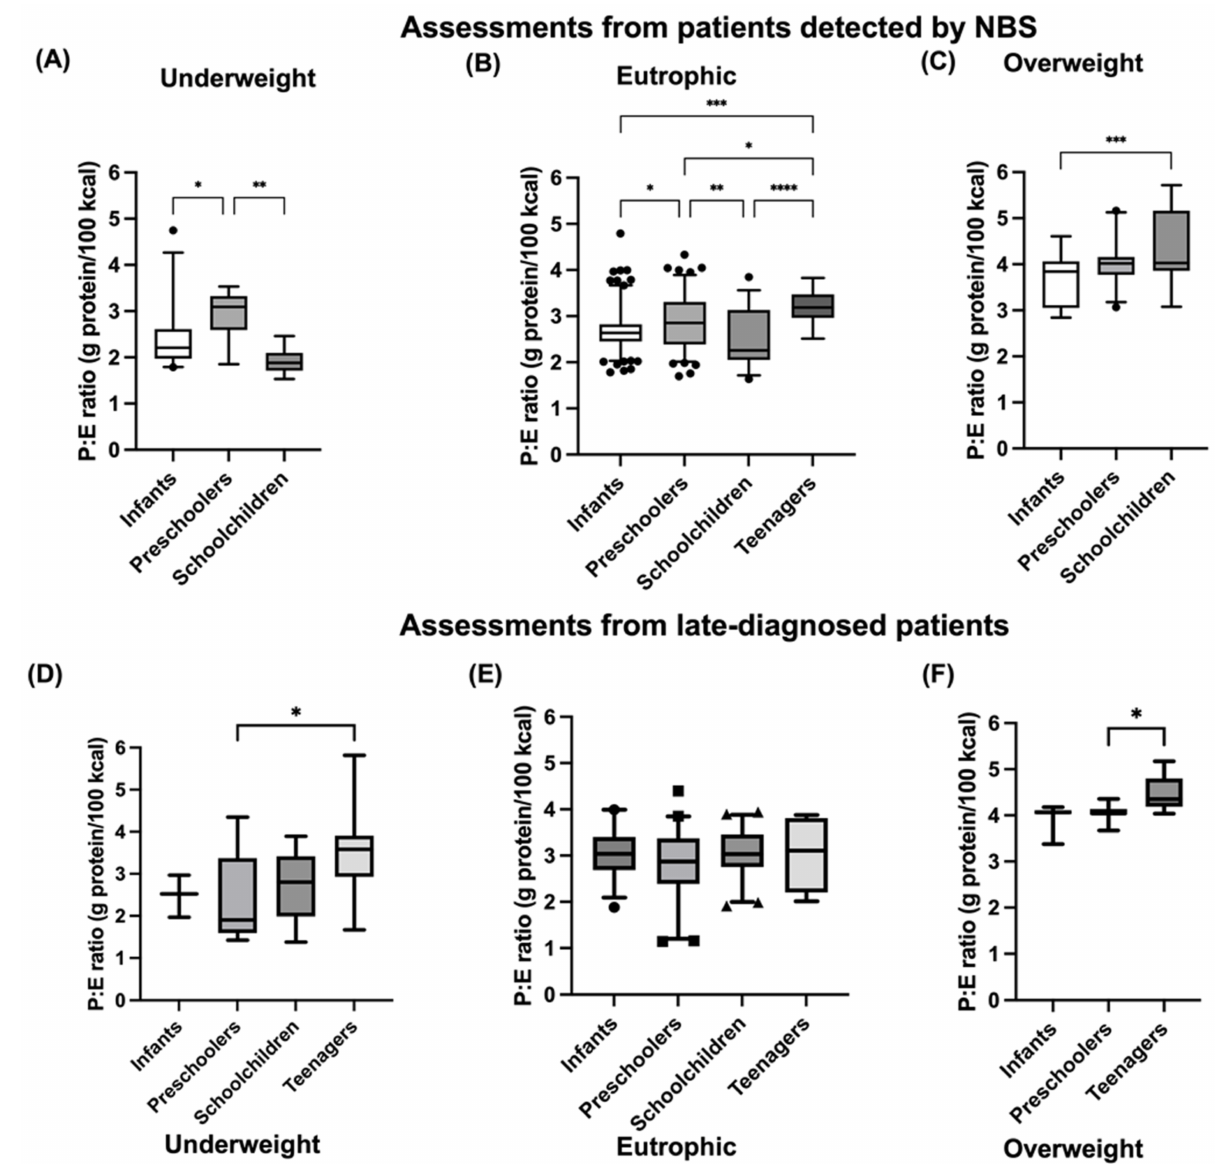
Figure 3. Protein: energy ratio of PKU patients according to age group and BMI Z-Score and type of diagnosis. Classified as underweight, eutrophic and overweight. P:E ratio was calculated from patient’s dietary recalls and is expressed as grams of protein per 100 kcal. P:E ratio is presented as median with 5–95th percentile. ( A ) P:E ratio according to age group and BMI Z- in underweight NBS assessments. ( B ) P:E ratio according to age group and BMI Z- in eutrophic NBS assessments. ( C ) P:E ratio according to age group and BMI Z- in overweight NBS assessments. ( D ) P:E ratio according to age group and BMI Z- in underweight late-diagnosed assessments. ( E ) P:E ratio according to age group and BMI Z- in eutrophic late-diagnosed assessments ( F ) P:E ratio according to age group and BMI Z- in overweight late-diagnosed assessments. Statistical differences between the studied age groups are shown. A p -value < 0.05 was considered statistically significant (* p < 0.05, ** p < 0.01, *** p < 0.001, **** p < 0.0001). Nutritional status was assessed according to BMI Z-Score. Age groups: infants (<2 years), preschoolers (2 years to <6 years), schoolchildren (6 to <11 years) and teenagers (11 to 18